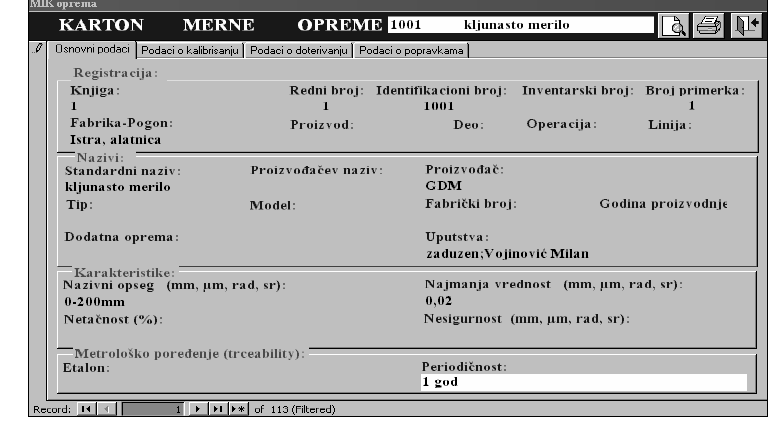
Figure 8 – Example of the window „Measuring equipment card“ Рис . 8 – Пример окна " Журнал измерительного оборудования “